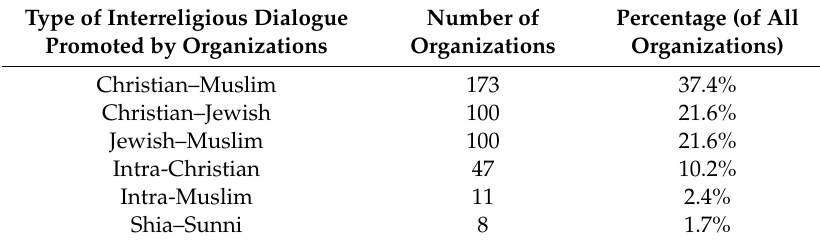
Table 1. Type of interreligious dialogue promoted by organizations in King Abdullah Bin Abdulaziz International Centre for Interreligious and Intercultural Dialogue (KAICIID) Peace Map 1